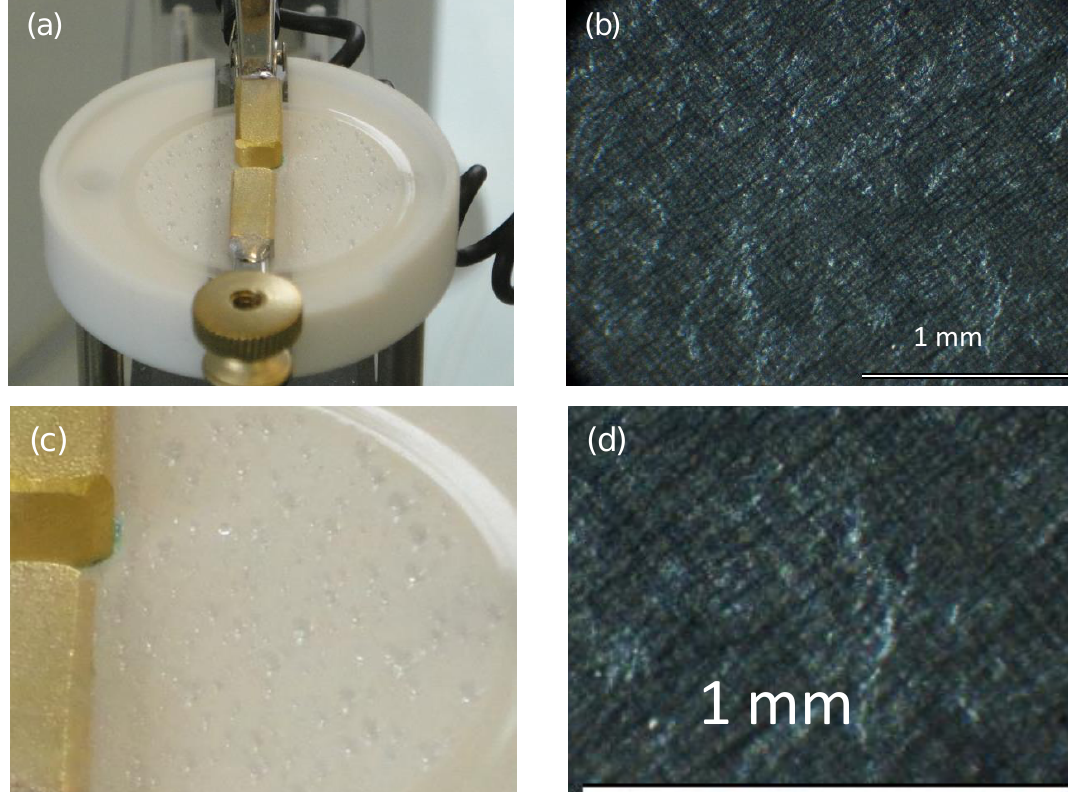
Figure 5. ( a ) Pure saline deposit after deliquescence onto a PTFE (Teflon)filter and ( b ) stereomicroscope image (Leica Wild M420, 64x enlargement) for a mixed saline and ES sample. ( c ) and ( d ) are the same as ( a ) and ( b ) with a higher magnification.